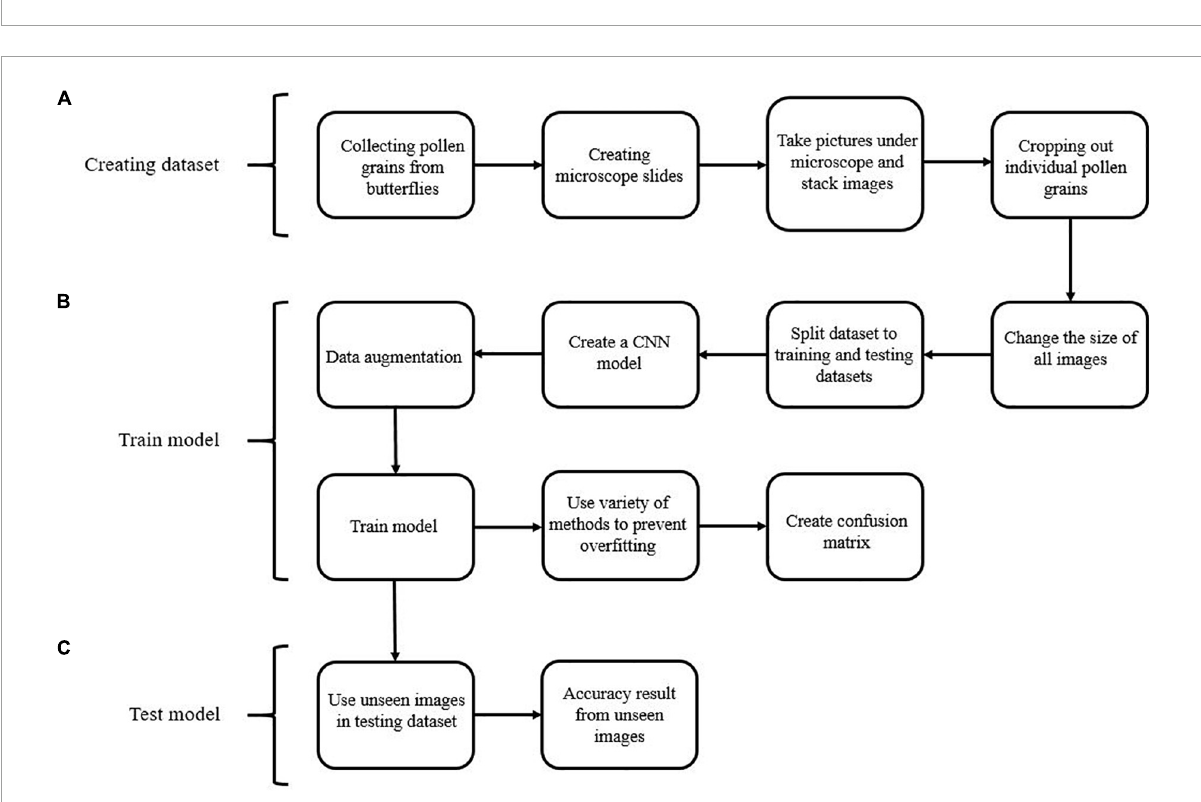
FIGURE4 Flowchart showing the pollen image classification process across several steps, including: (A) creating the image dataset; (B) training the model; (C) testing the